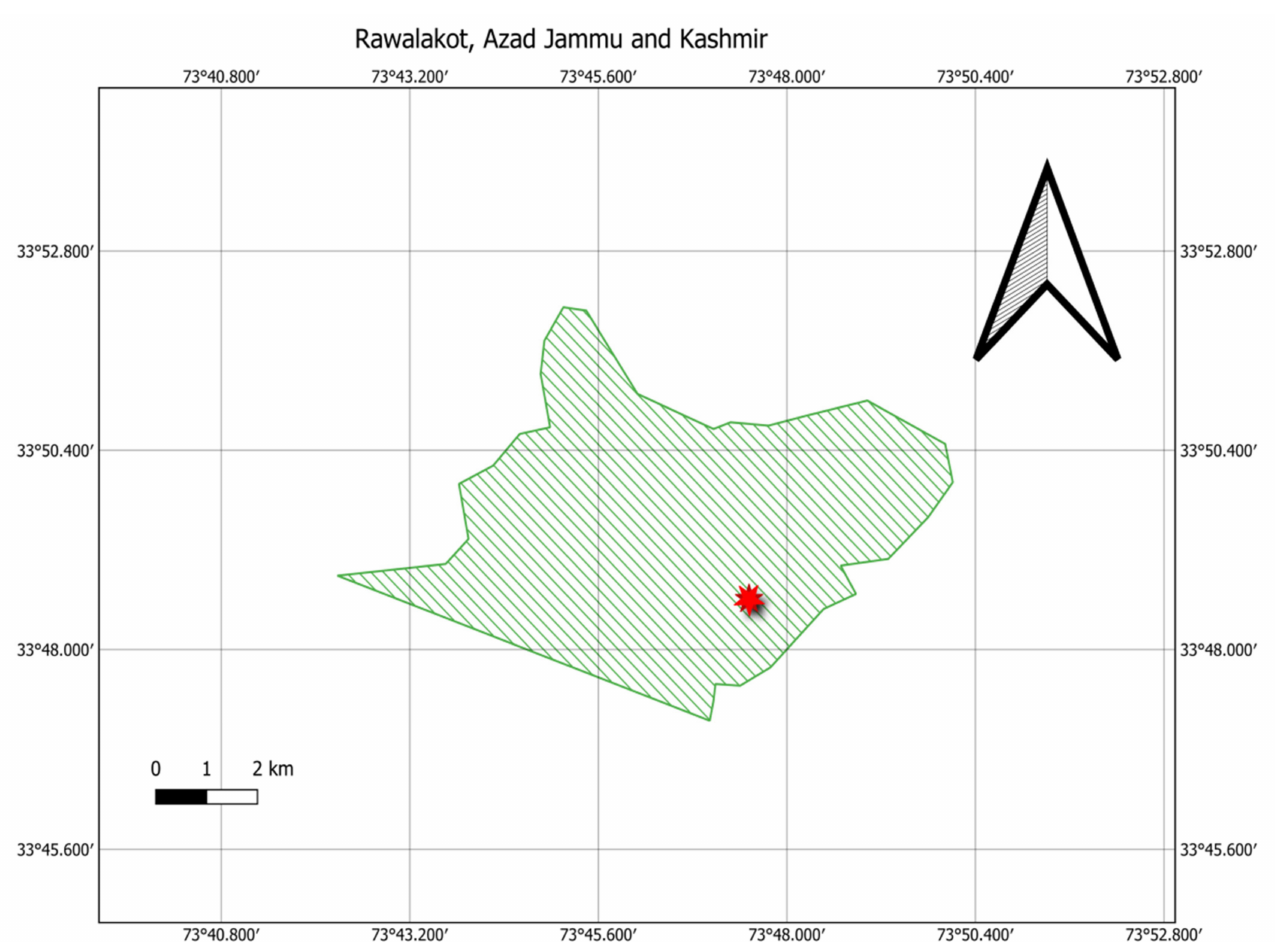
Figure 1. The location of the trial map (Rawalakot, District Poonch, Poonch, Azad Jammu and Kashmir, Pakistan) prepared for this study with the help of QGIS software (version 3.24.3, Bern, Switzerland), whereby the red star indicates the approximate location of the trial and the half-arrow depicts the North